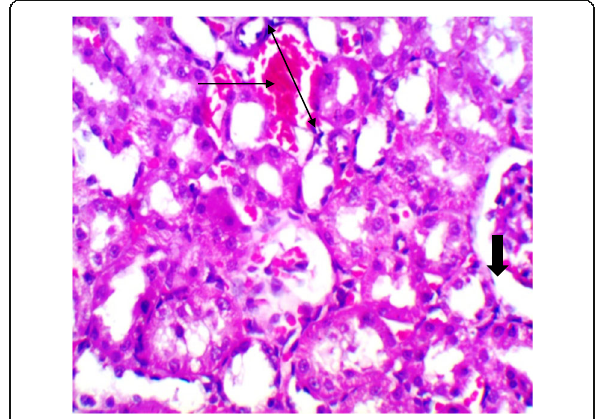
Fig. 16 Photomicrograph of CCl4-treated kidney sections showing congestion (arrow), vacuolation, inflammatory changes (2head arrow) and periglomerular space (thick arrow) (H&E;